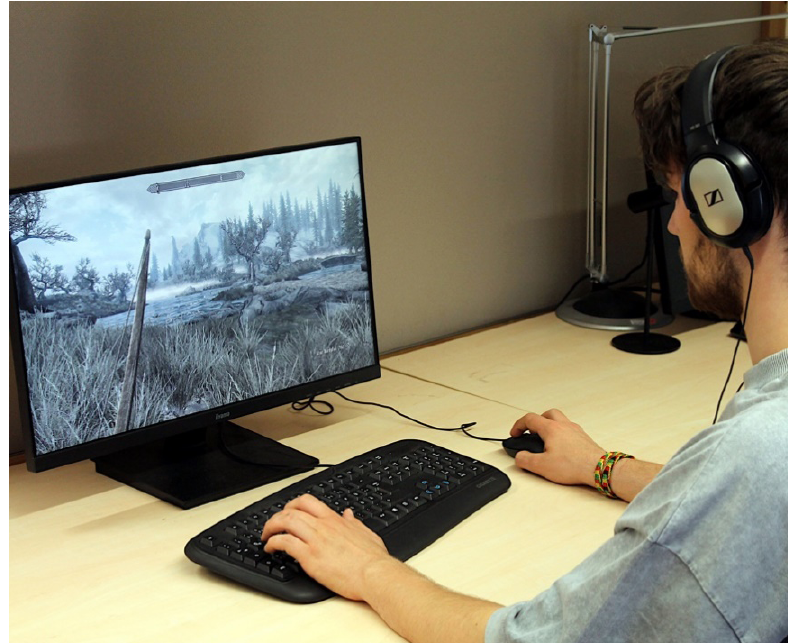
Figure 2. Laboratory setup of the traditional desktop gaming experimental